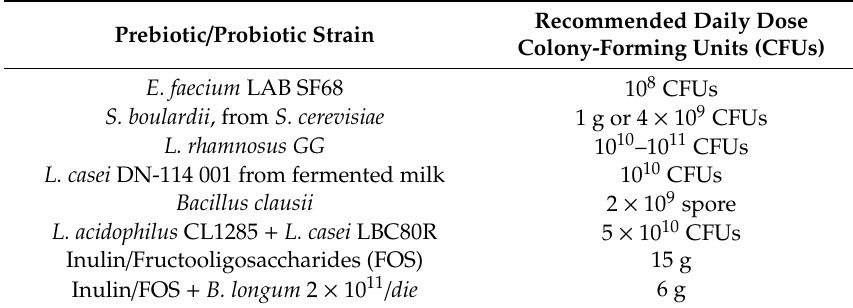
Table 3. Dietary interventions with representative prebiotics and